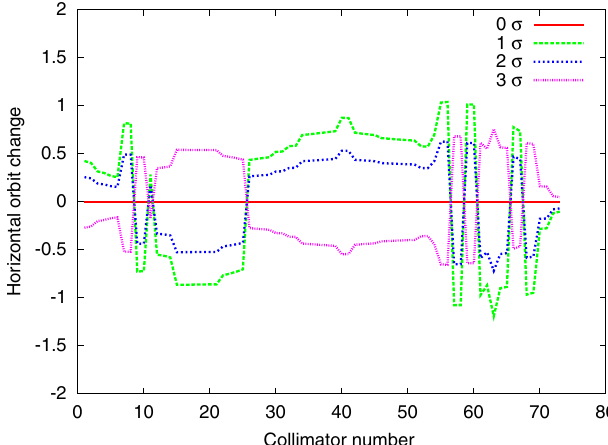
FIG. 21. (Color) Crab dispersion (IP5 is at 13 329 m) due to one 800-MHz global crab cavity (red) and one 400-MHz global crab cavity (green); normal dispersion